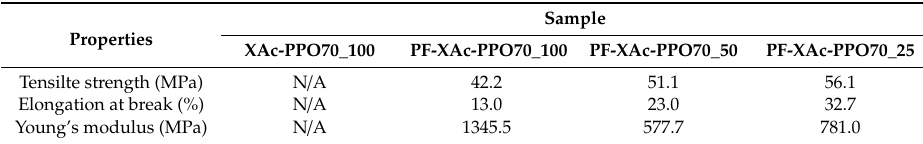
Table 1. Mechanical properties of crosslinked pore-filling membrane.